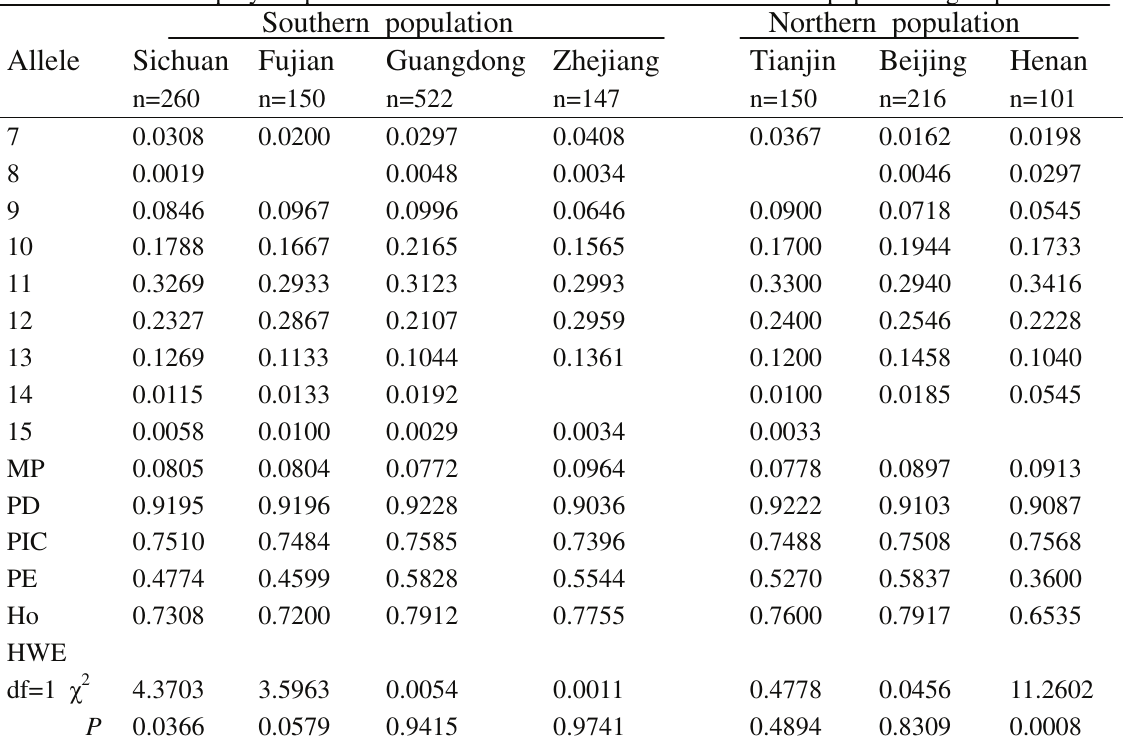
Table S12- Genetic polymorphism at the D5S818 locus for the seven Chinese population